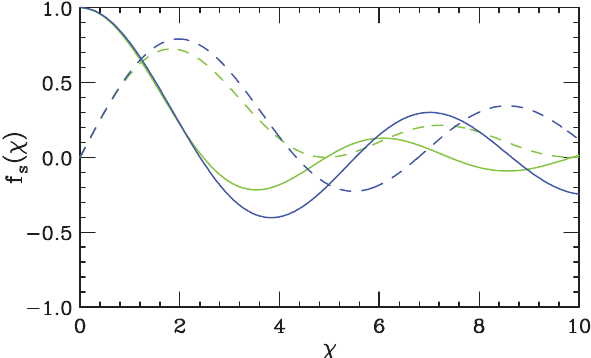
ð χ Þ . The real and the imaginary FIG. 6. The complex function f s ð χ Þ are denoted by the green solid and the green dashed parts of f s lines, respectively. For comparison, the function f ð χ Þ for the parabolic potential is also plotted. Its real and imaginary parts are denoted by the blue solid and the blue dashed lines, respectively.